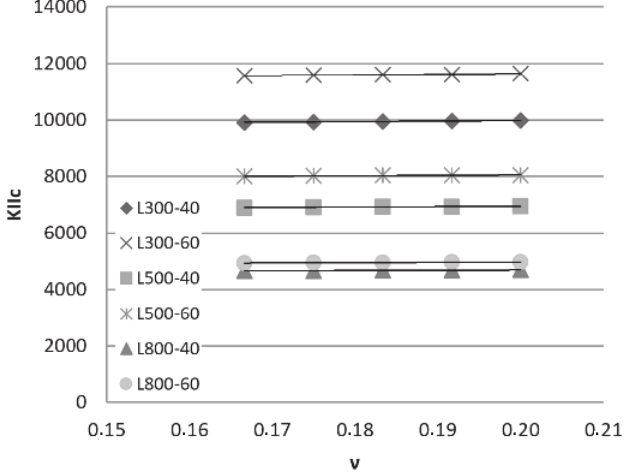
Figure 17 K ’s variation according to Poisson’s coefficient